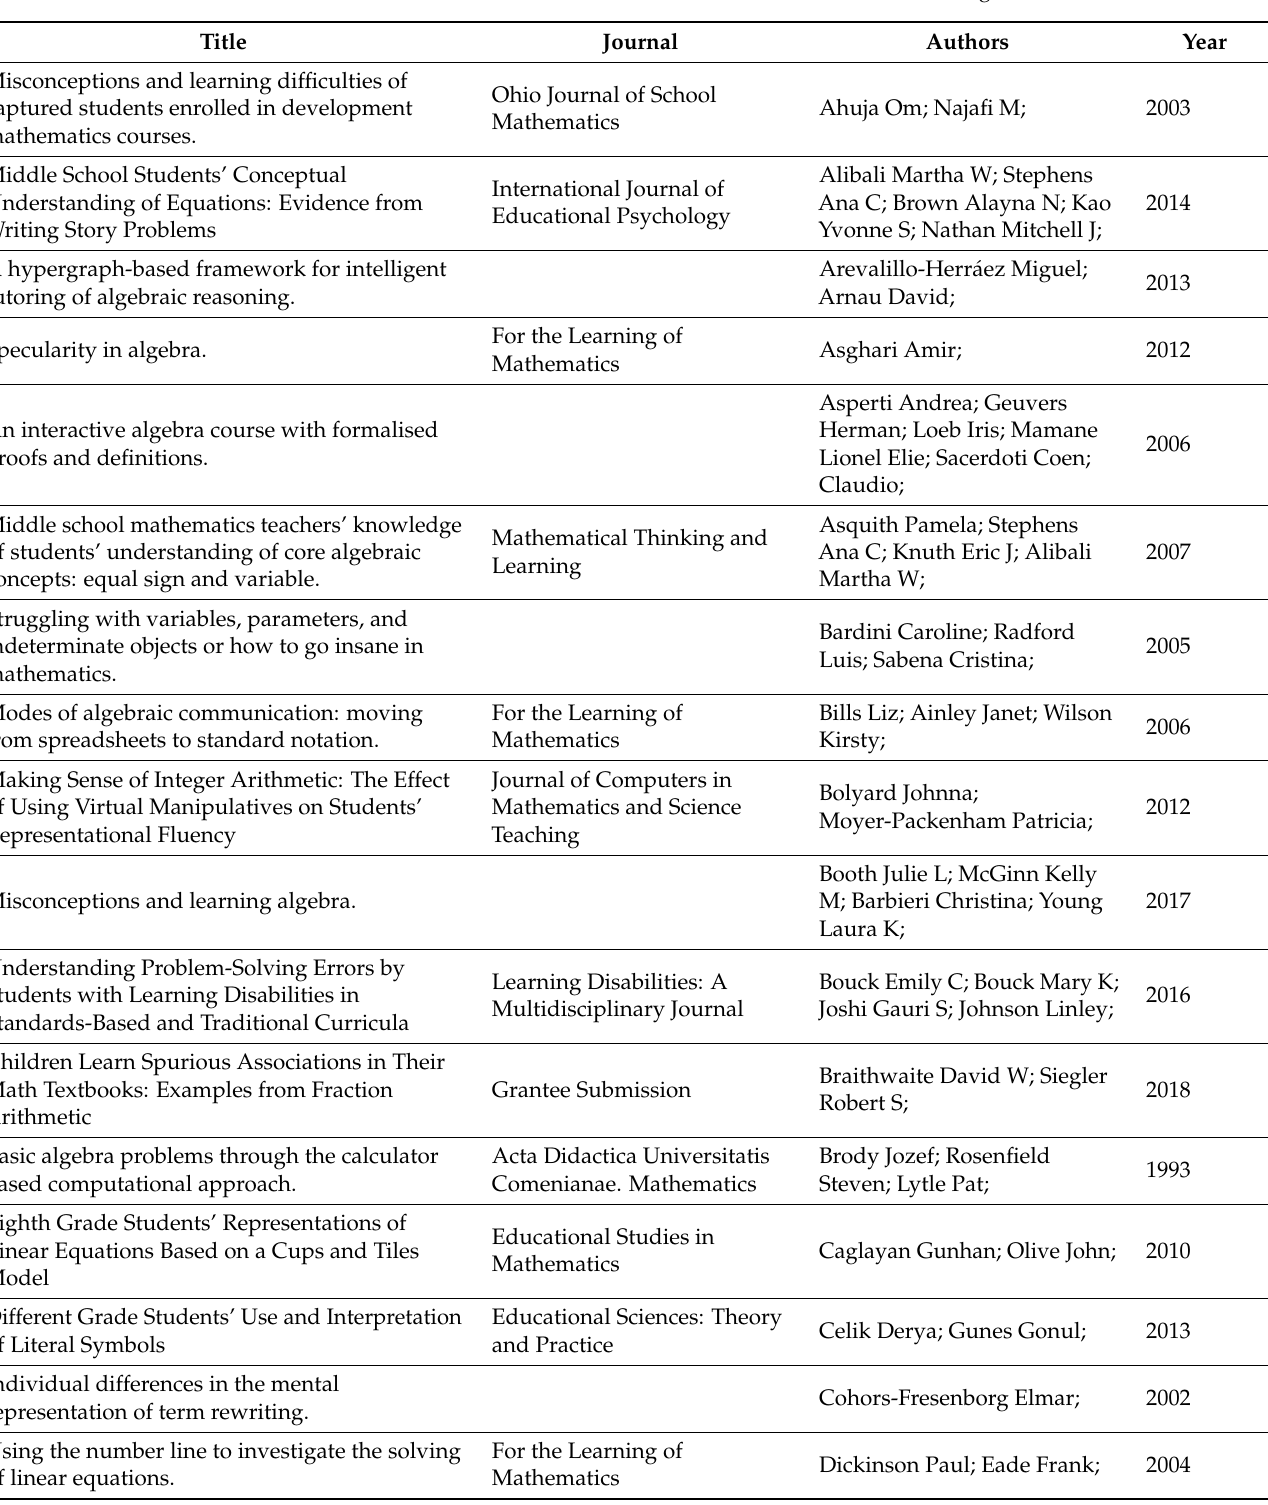
Table A1. References That Formed the Basis for the Literature